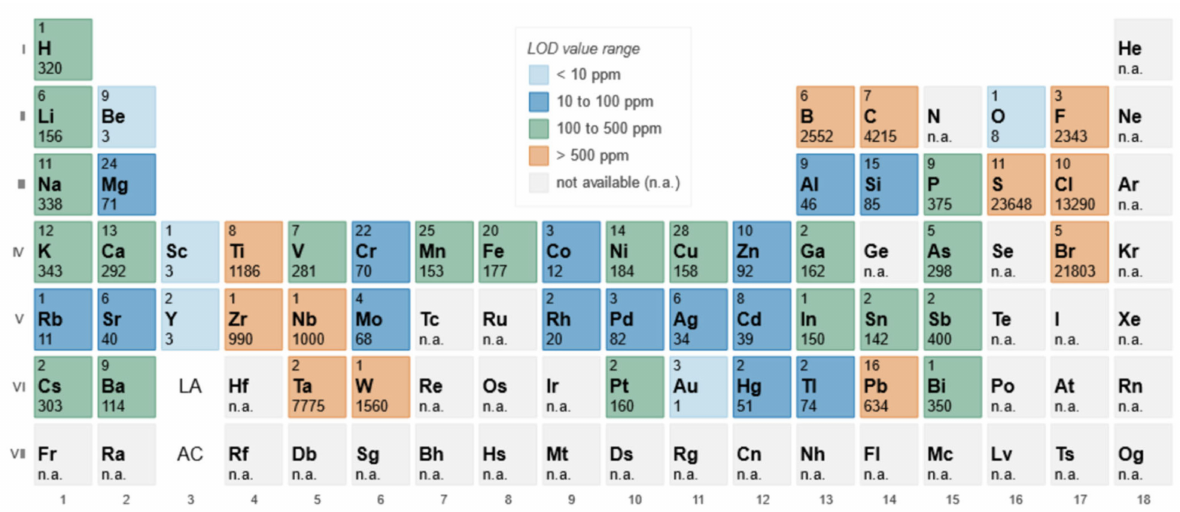
Figure A3. LOD values reported for LIBS analysis of solid materials (data: www.LIBS-info.com [50], accessed on 31 May